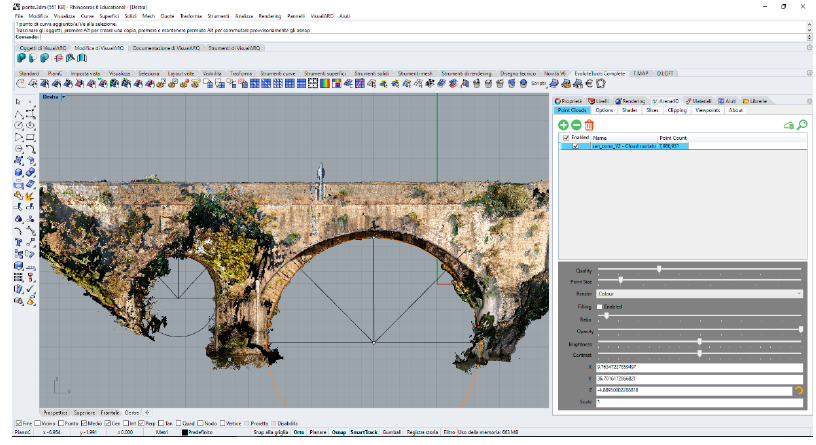
Figure 9. Scheme of the position of the